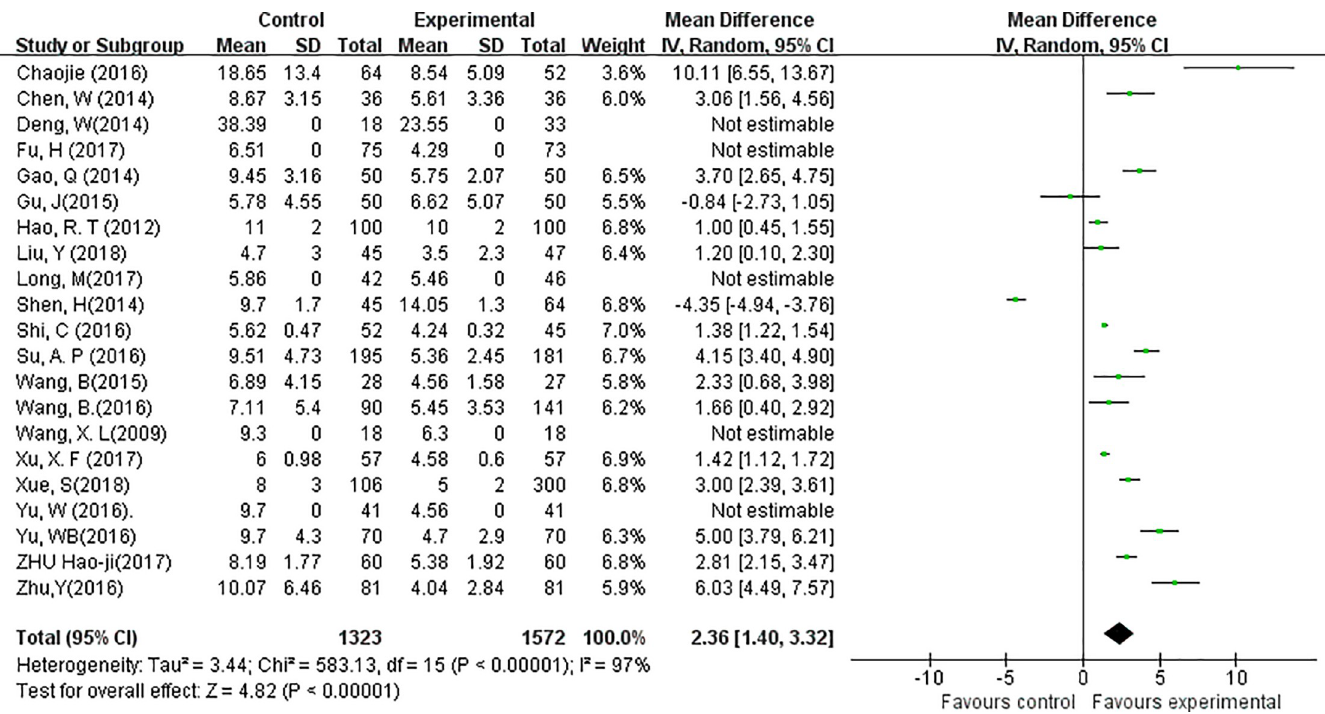
Fig 3. Forest plots of the total number of lymph nodes harvested in groups. (Experimental = Carbon nanoparticle group, Control = Blank or methylene blue group, Total = total number of LN harvested, Mean = the average number of LN harvested in each patient, SD = Standard deviation).